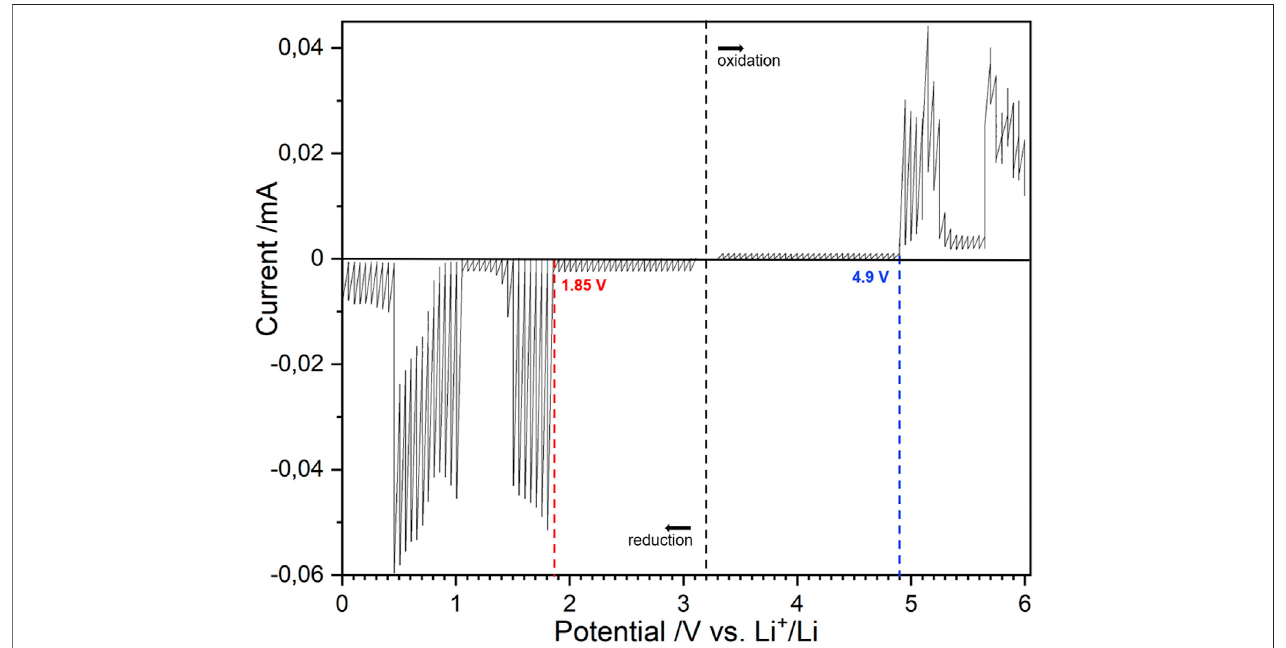
FIGURE 3 | PITT measurements on a stack LAGP-Au/LAGP represented using the current response as a function of potential. The two measures were taken on twodistinctstacksat60 ° C,fromE